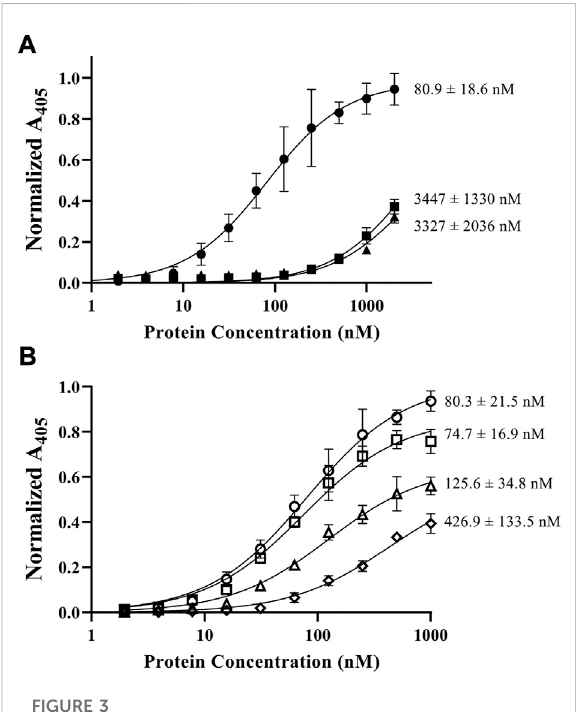
FIGURE 3 ELISA results of fVIII C domain constructs binding to phosphatidylserine-coated plates. Dissociation constants ( K D ) are denoted attheend ofeach curve. (A) Comparison ofC1C2 (closed circle), C1 (closed square), and C2 (closed triangle) to lipid unilamellular vesicles (80% PC/20% PS) in TBS. (B) Comparison of fVIII C1C2 construct af fi nity to phospholipids (80% PC/20% PS) in 50 mM (open circle), 100 mM (open square), 150 mM (open triangle), and 225 mM (open diamond)